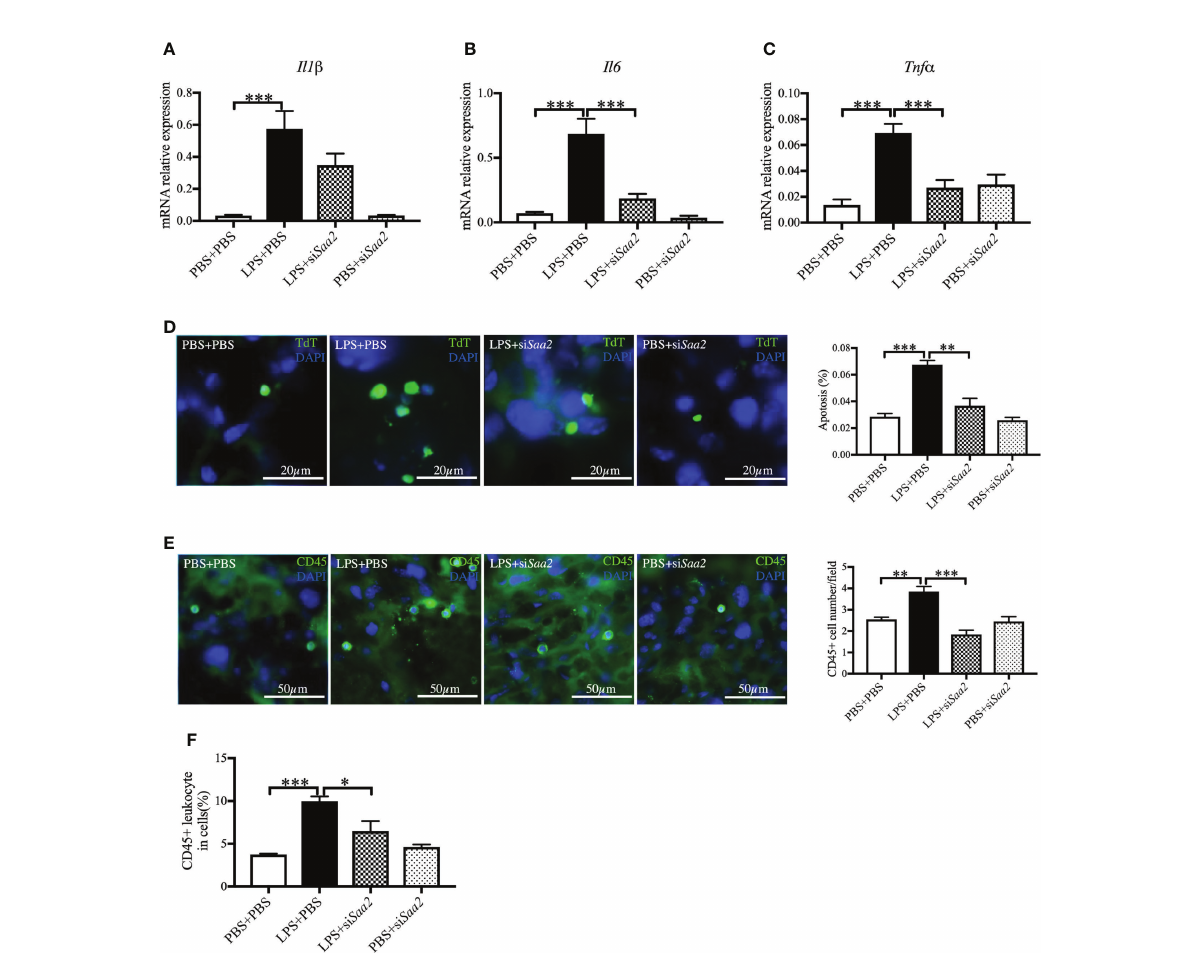
FIGURE 5 siRNA against Saa2 inhibits placental Il6 and Tnf a expressions induced by intrauterine in fl ammation. On embryonic (E) day 17, pregnant CD-1 mice underwent a mini-laparotomy in the lower abdomen for intrauterine injection of lipopolysaccharide (LPS). One hour later, dams received intravenous injection of siRNA against serum amyloid A 2 (si Saa2 ) or phosphate-buffered saline (PBS). At 24 h postinjection (hpi), dams were sacri fi ced. Placentas were harvested from each dam, and real time-quantitative polymerase chain reaction (RT-qPCR) was performed to evaluate the effect of siRNA treatment. The levels of Il1 b (A) , Il6 (B) , and Tnf a (C) were statically compared between groups. PBS+PBS, n = 6; LPS+PBS, n = 10; LPS+si Saa2 , n = 7 – 9; PBS+si Saa2 , n = 6. (D) Apoptotic rates of placental cells treated as indicated were detected by terminal deoxynucleotidyl transferase dUTP nick end labeling (TUNEL) staining. Representative images for positive cells were labeled by TdT (green) and DAPI (blue, nucleic staining) in the labyrinth of placentas. Scale bars: 20 m m. (E) Representative fl uorescence immunostaining for CD45+ (green) and DAPI (blue, nucleic staining) in the labyrinth of placentas. Scale bars: 50 m m. (F) The ratio of CD45+ leukocytes in fi ltrated in the placenta were statically compared between groups by fl ow cytometry. Each group, n = 4. Values are expressed as mean ± SEM, * p < 0.05, ** p < 0.01, *** p < 0.001 by one-way